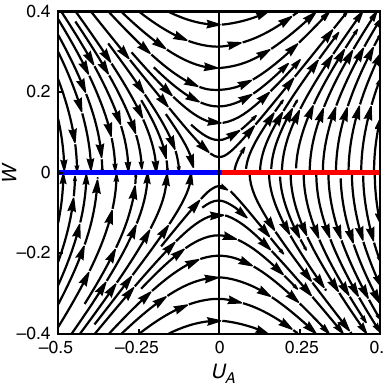
FIG. 8. RG flow diagram in the ð U one-dimensional limit [obtained by taking n → ∞ in Eq. (31) and setting ϵ ¼ 0 in Eq. (32)]. The stable (unstable) line of fixed points is indicated in blue (red). The flow determines the charge sector Kosterlitz-Thouless transition [42].